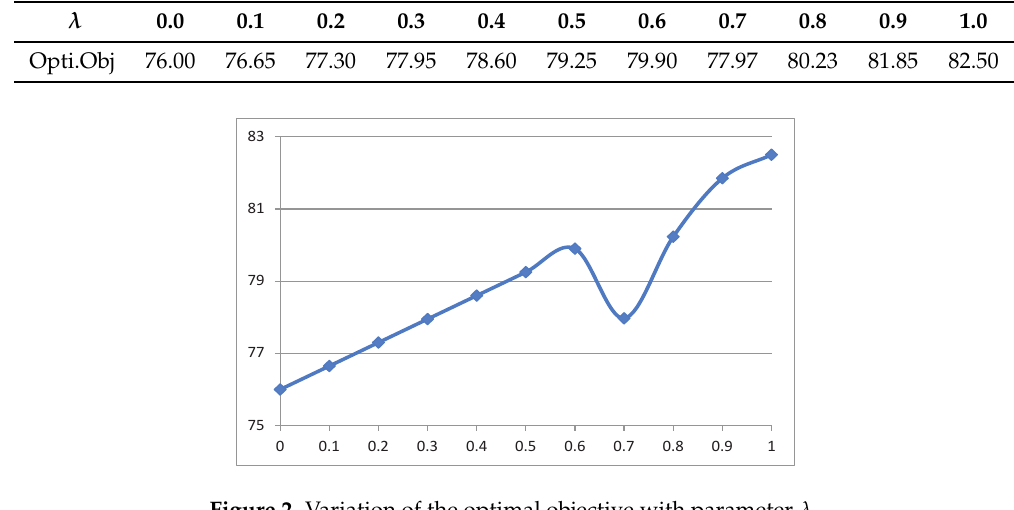
Figure 2. Variation of the optimal objective with parameter λ